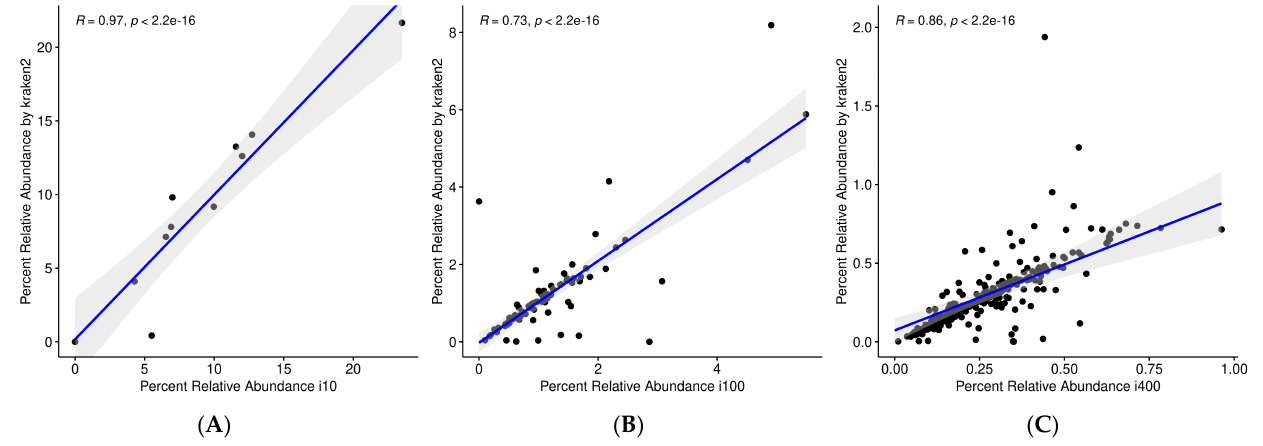
Figure 7. Correlation plots between the relative abundance of microorganisms detected by Kra- ken/Bracken pipeline and Reference . Each plot represents the Spearman correlation between the relative abundance in the 10 species ( A ), 100 species ( B ) and 400 species ( C ) datasets from Mendo and collaborators, along with the obtained correlation coefficient.